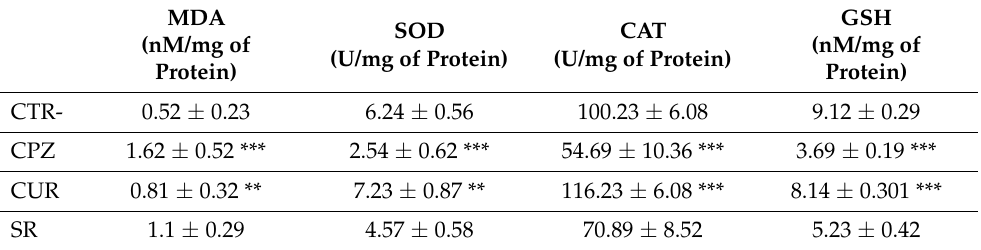
Table 1. Effect of curcumin on the oxidative stress markers induced by cuprizone administration in mice. MDA GSH SOD CAT (nM/mg of (nM/mg of (U/mg of Protein) (U/mg of Protein) Protein) Protein) CTR- 0.52 ± 0.23 6.24 ± 0.56 100.23 ±